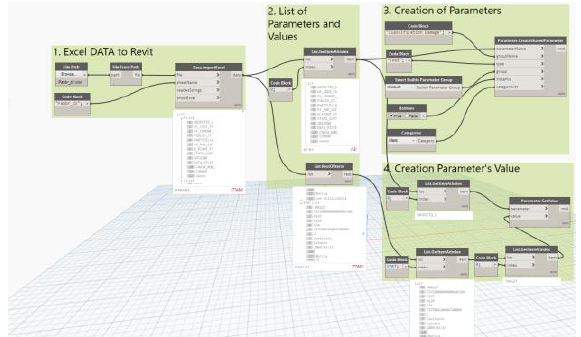
Figure 10. Dynamo visual scheme providing the assignment of damage codes to the Norcia buildings BIM models.